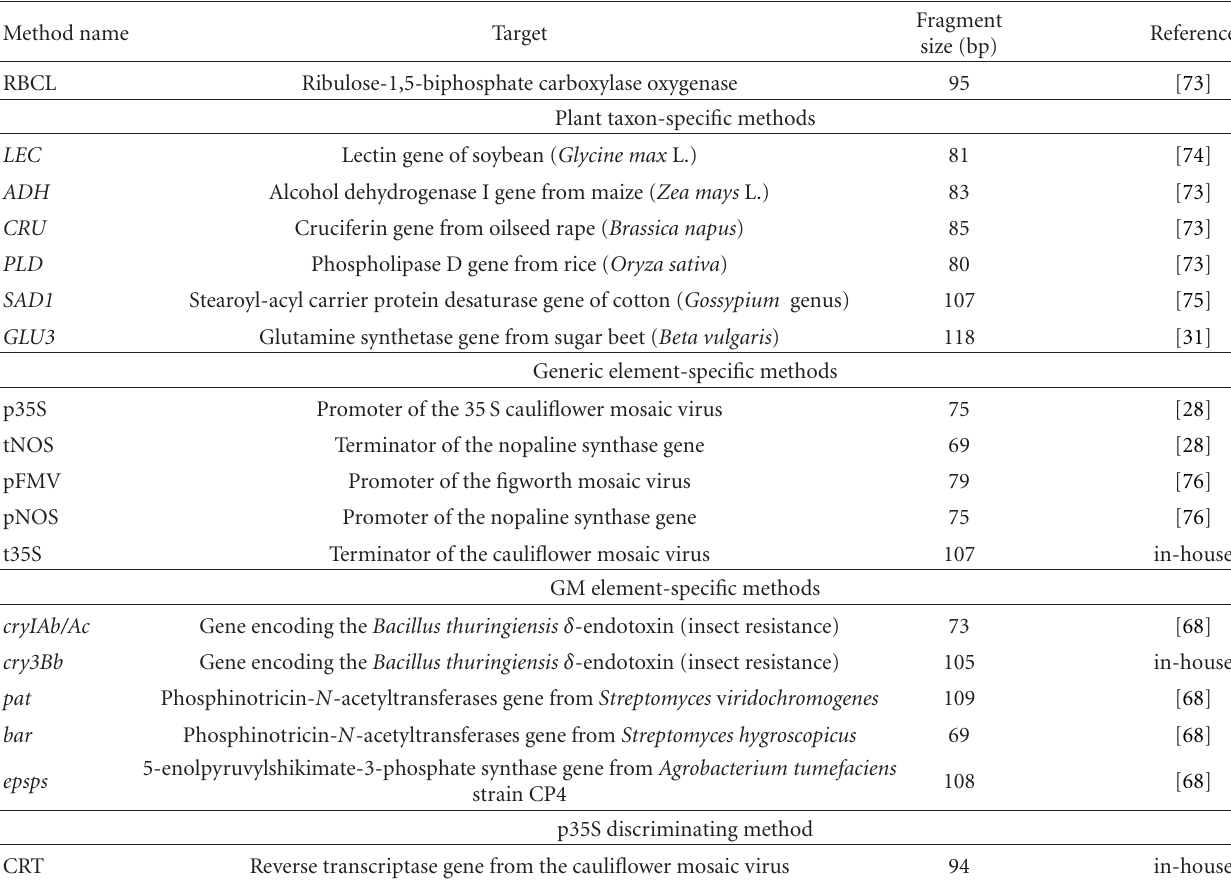
Table 1: List of SYBR Green screening methods developed and validated at